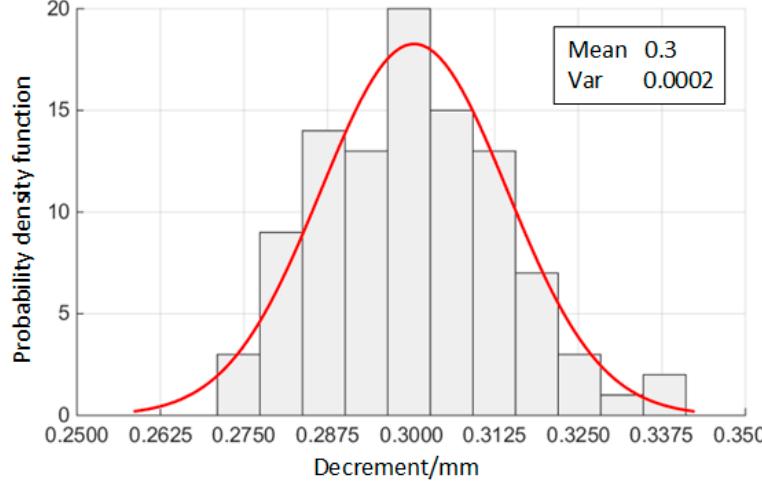
Figure 10. Distribution of decrement.